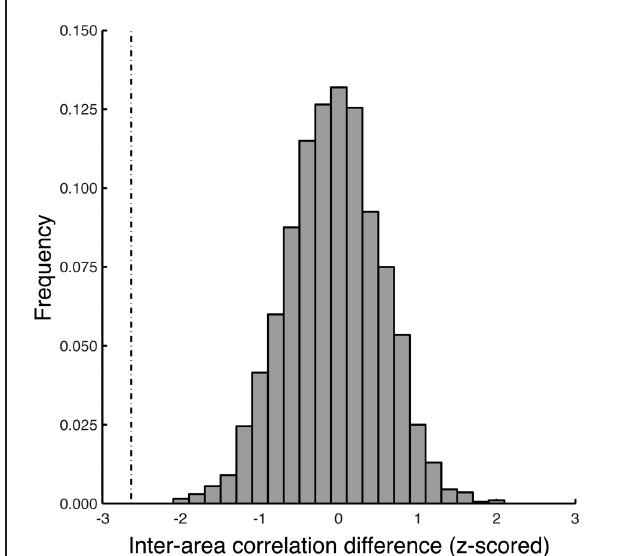
FIGURE 2 | Randomization test. Non-parametric randomization tests were used to assess the statistical significance of the inter-area correlation differences. Histogram, example null distribution (Fisher-transformed correlation values) computed by randomly permuting the Fourier phase of the fMRI response time-series without changing the amplitude (see Methods for details). Dashed vertical line, measured difference in inter-area correlations between the extrinsic and intrinsic systems for focused attention vs.